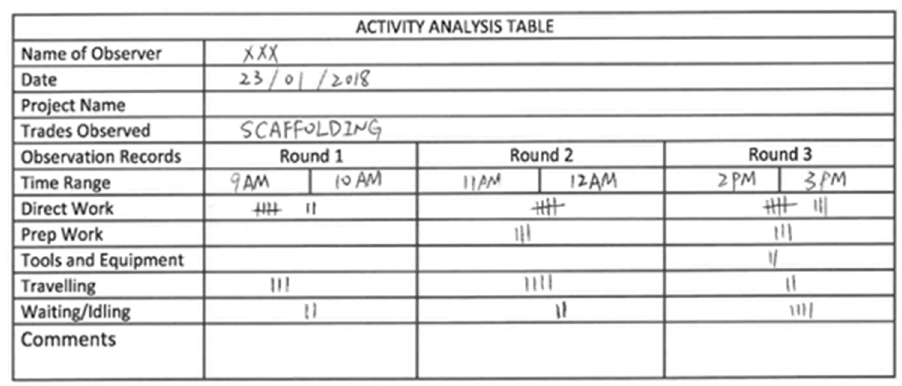
Figure 1. An example of a workface assessment.